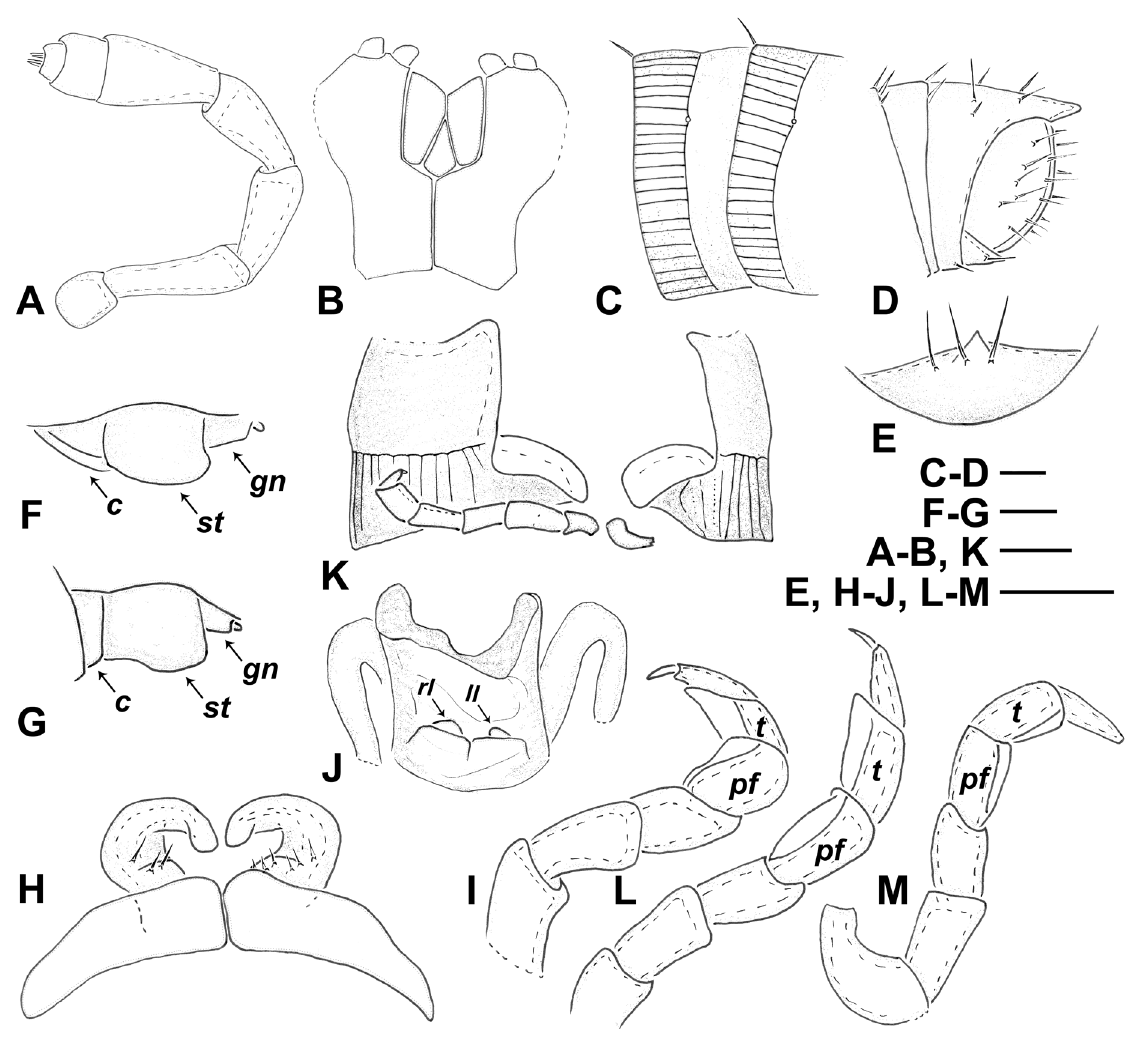
Fig. 1. Non-gonopod characters of Enghopyhllum gen. nov., males. A . Right antenna. B . Gnathochilarium. C . 8 th and 9 th body rings. D . Telson. E . Subanal scale. F . Mandibular stipital (“cheek”) lobe, lateral view. G . Mandibular stipital (“cheek”) lobe, ventro-lateral view. H . First leg-pair. I . Second leg-pair. J .